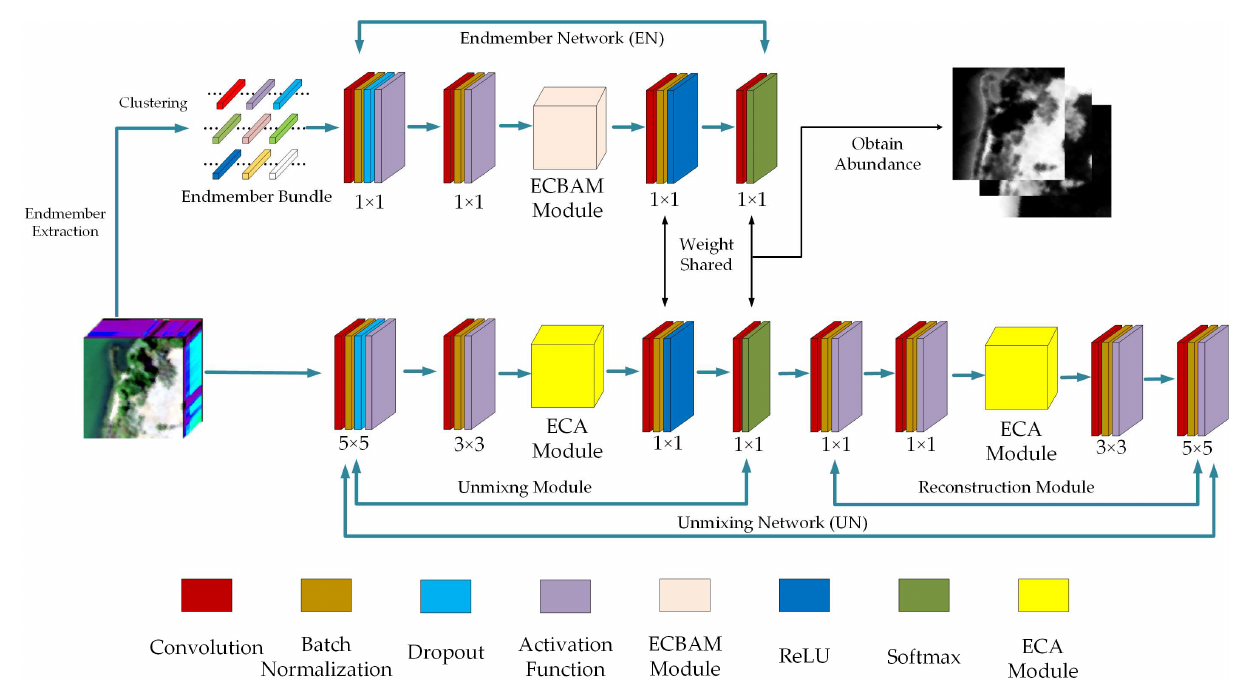
Figure 1. Network architecture of the proposed efficient attention-based convolutional neural network (EACNN).